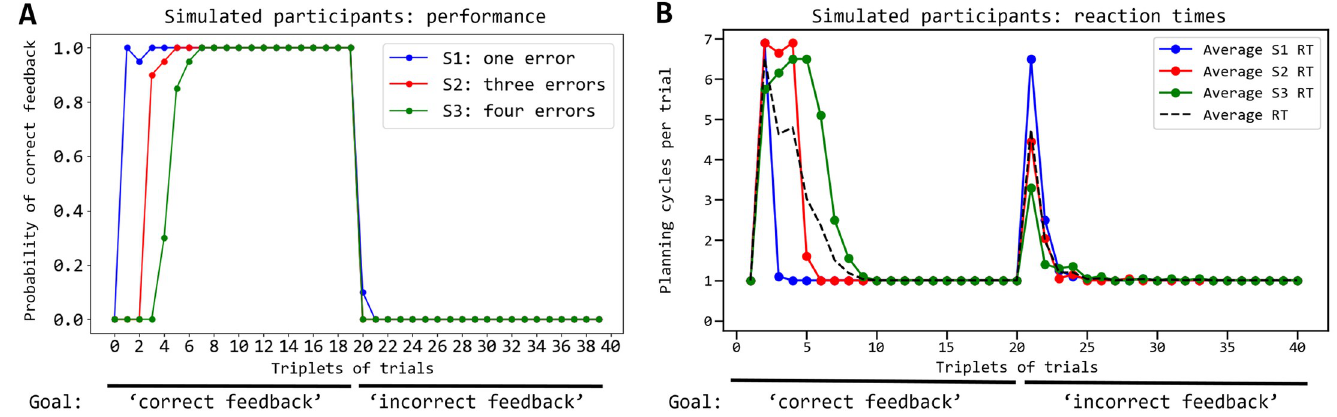
Fig 9. Behaviour of the system when the goal is switched to a new one, averaged over 20 simulated participants. (A) Performance, averaged over the simulated participants, measured as probability of selection of the correct action (y-axis) along the trial triplets (x-axis); the pursued goal is switched from getting a ‘correct feedback’ to getting an ‘incorrect feedback’ at triplet 20. (B) Average reaction times measured during the same experiment shown in ‘A’.